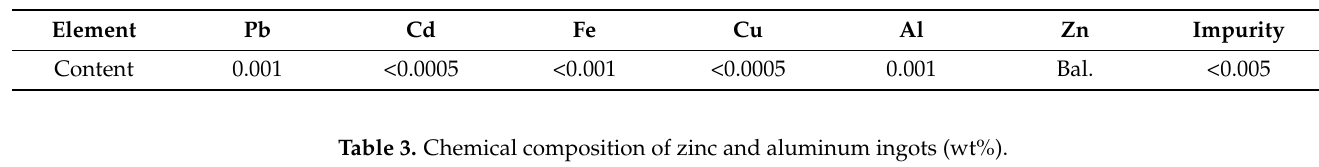
Table 2. Chemical composition of zinc ingots (wt%).